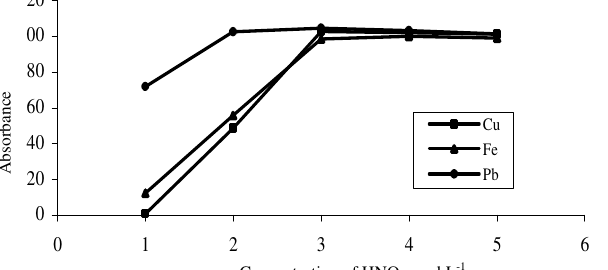
Figure 3. Effect of HNO concentration as eluent on the recovery of 5 mg L -1 Fe and 2.5 mg L -1 3 of Cu and Pb ( n =